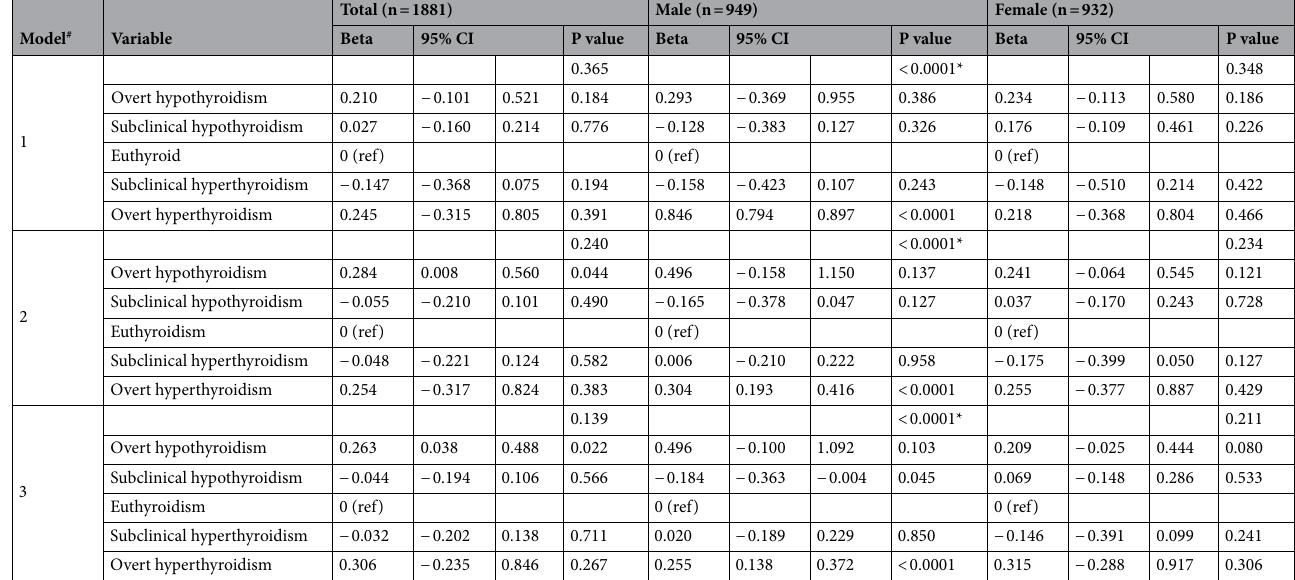
Table 5. Association between categorical thyroid function and HOMA-IR index. # Model 1: linear regression analysis, 2: multiple regression analysis after adjustment for age, sex, systolic blood pressure, BMI, alcohol consumption, 3: multiple regression analysis after adjustment for age, sex, systolic blood pressure, waist circumference, alcohol consumption; HOMA-IR is logarithmic-transformed. * P -values < 0.05 were considered as statistically